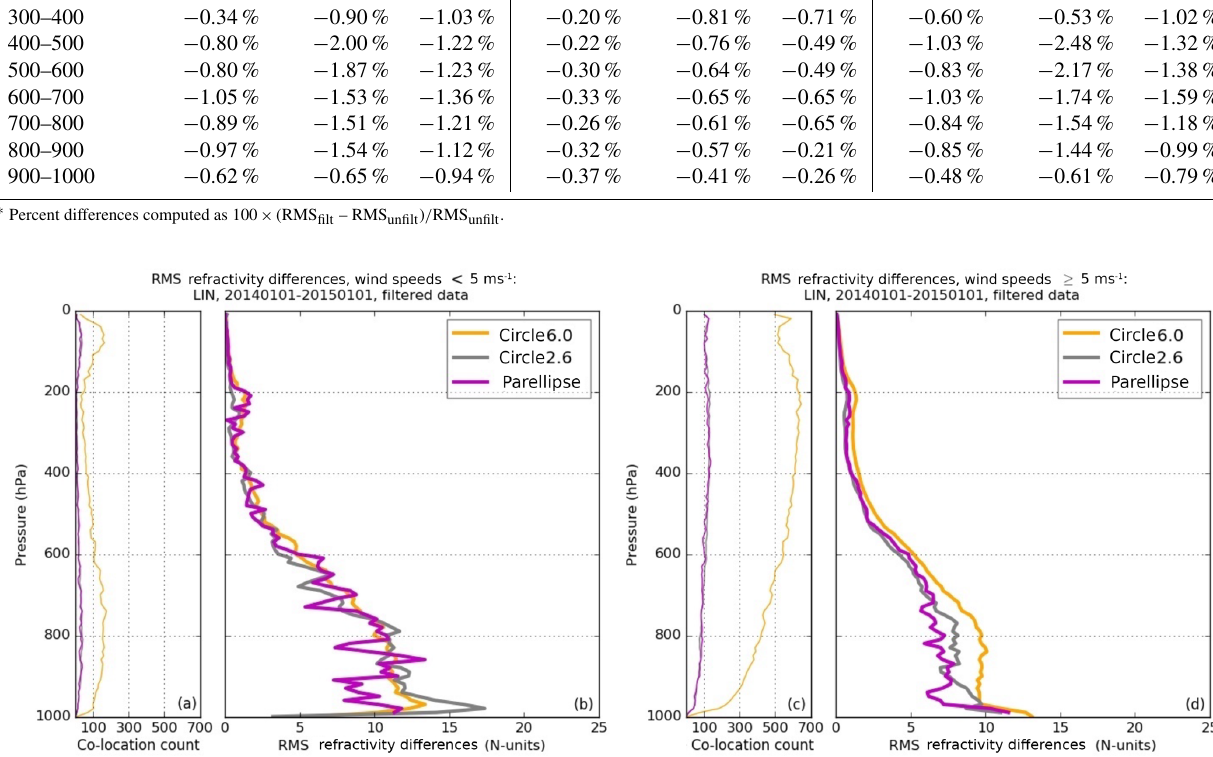
Figure 4. RMS refractivity differences at Lindenberg 2014 for two sets of RO–RS pairs separated by reported RS wind speeds: pairs with wind speeds less than 5ms − 1 (a, b) and pairs with wind speeds greater than or equal to 5ms − 1 (c, d) . Geometric constraints are shown in the following colors: large circle (orange), small circle (grey), and ellipse